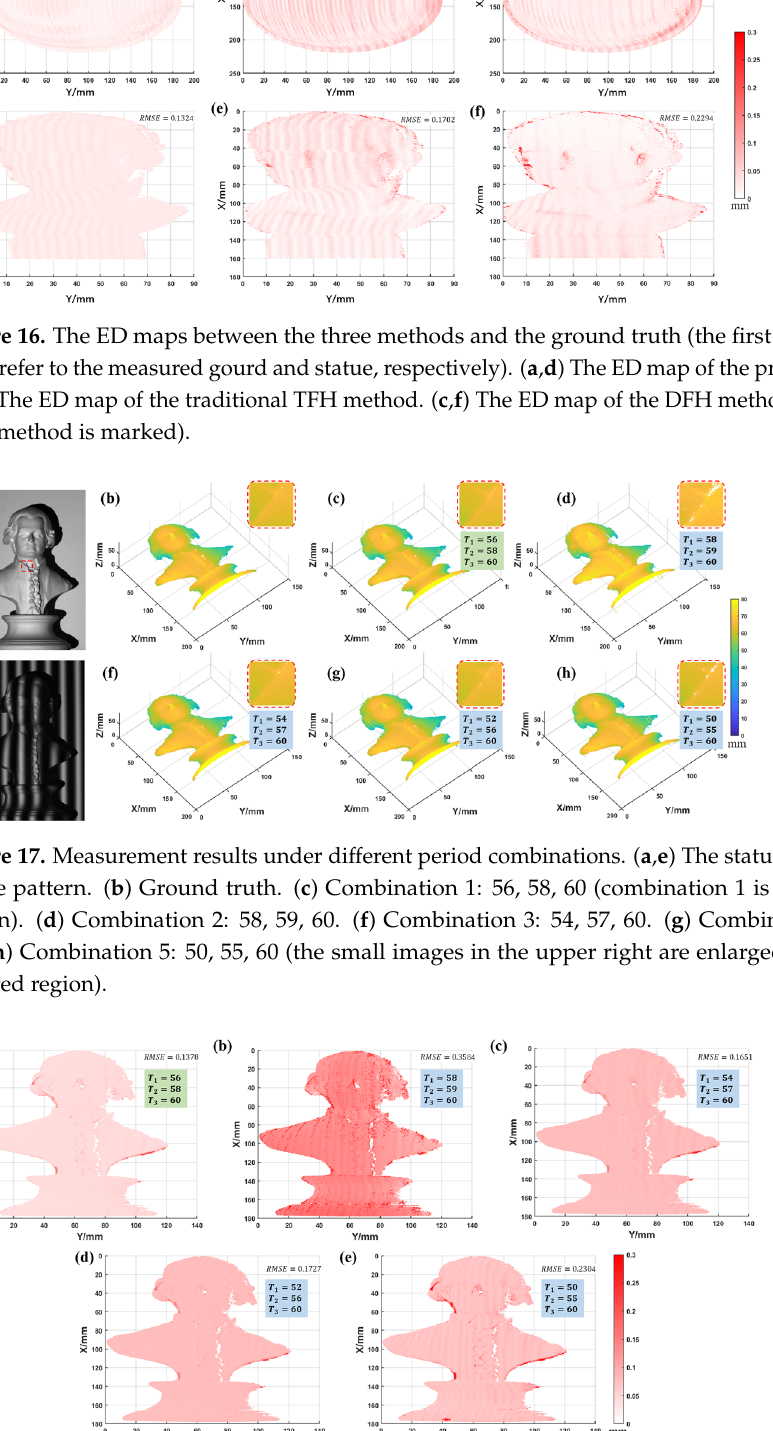
Figure 18. The ED maps between the different period combinations and the ground truth. ( a ) Com- bination 1: 56, 58, 60 (combination 1 is optimal combination). ( b ) Combination 2: 58, 59, 60. ( c ) Com- bination 3: 54, 57, 60. ( d ) Combination 4: 52, 56, 60. ( e ) Combination 5: 50, 55, 60 (the RMSE of each combination is marked).